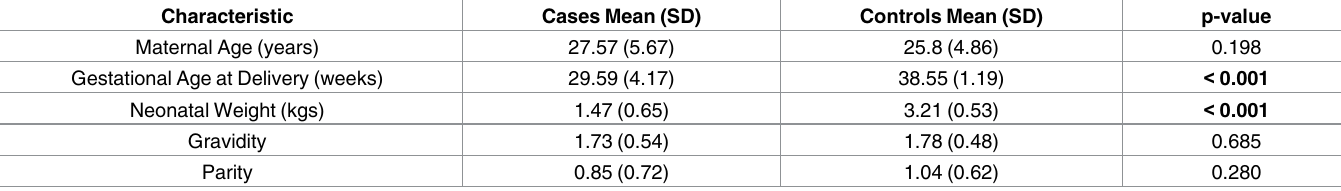
Table 1. Characteristics of the study population in the initial WES set.